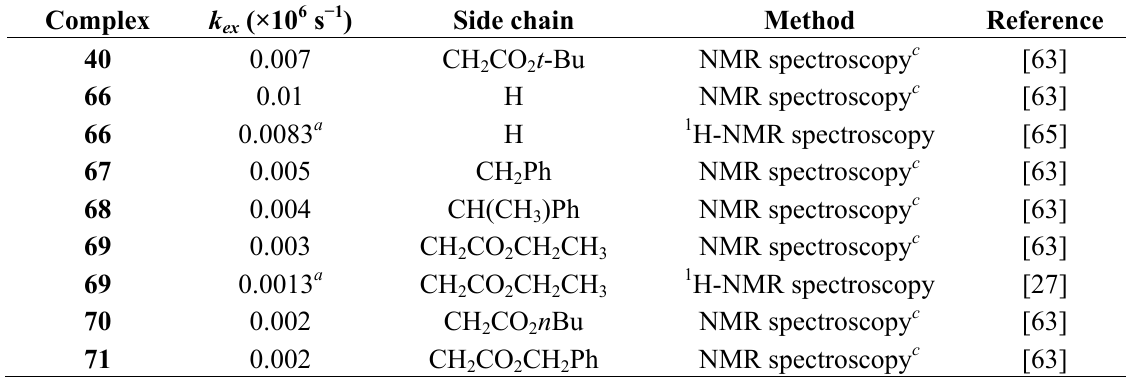
Table 4. Water-exchange rates of Eu III -containing DOTA-tetraamide complexes 40 and 66 – 80 discussed in Section